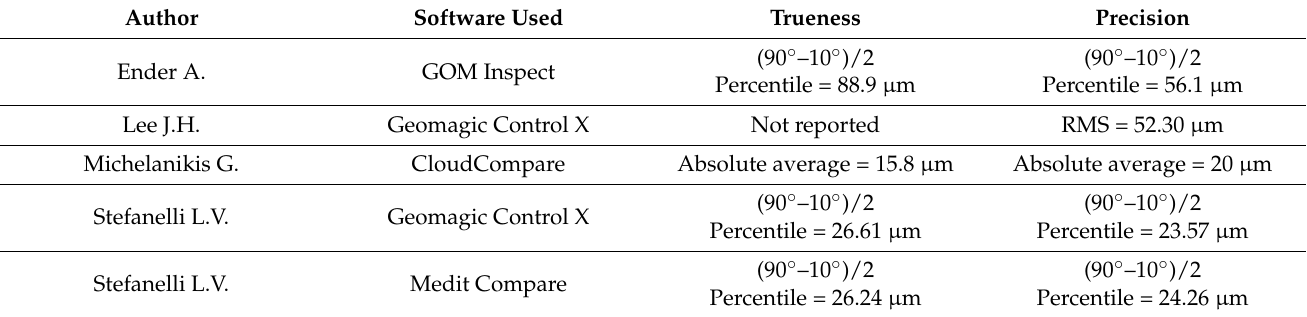
Table 3. Different accuracy values, in terms of trueness and precision, reported by several authors, when a full dental arch is scanned by Medit I-500. Author Software Used Trueness Precision Ender